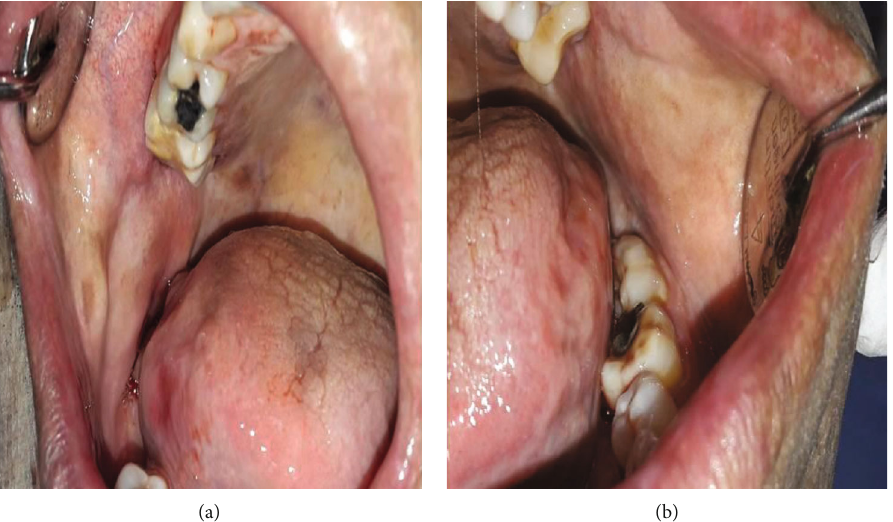
Figure 3: Intraoral view: inner sides of the cheeks. Widespread redness with erythema, erosions, and some pigmented lesions induced by